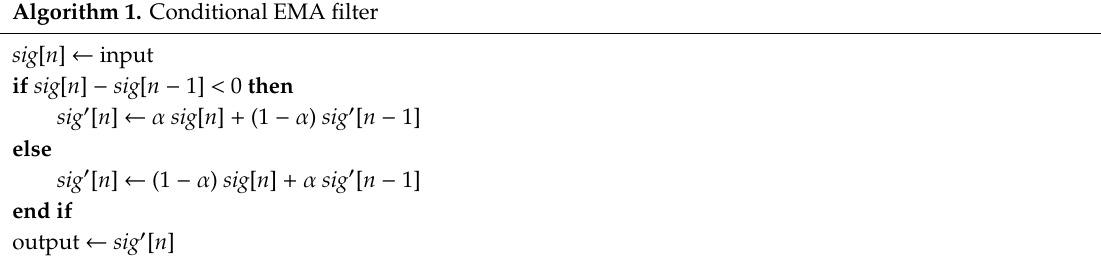
Algorithm 1. Conditional EMA